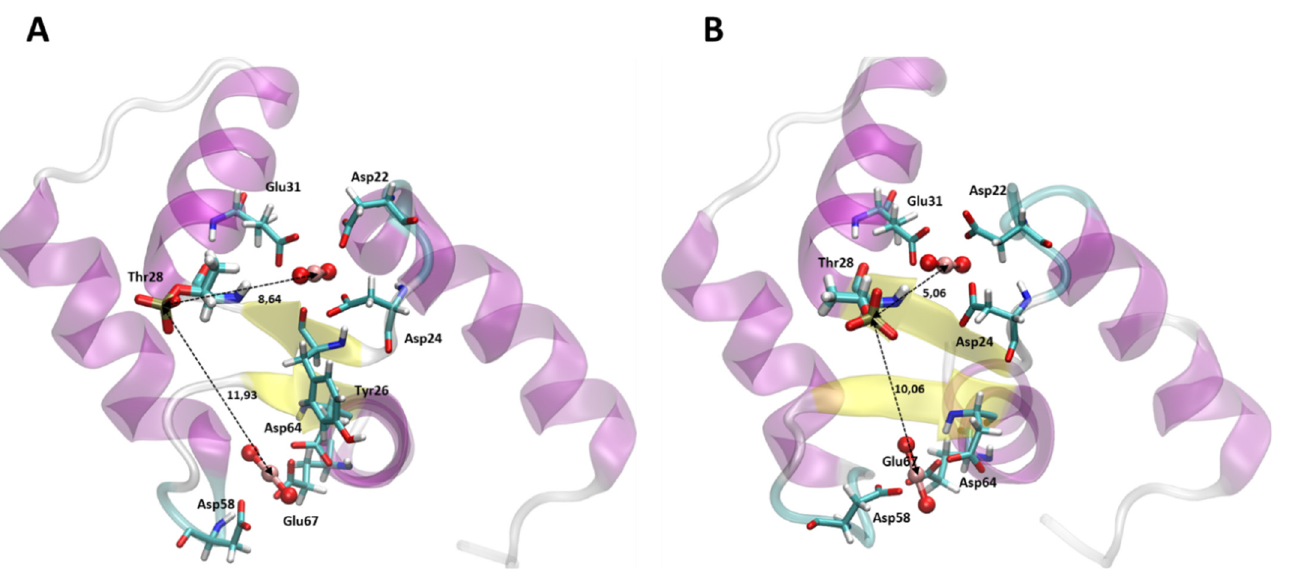
Figure 6. Structures of the calmodulin CaM1 Y I-II P system obtained after 12 ns MD simulation with a polarized force field ( A ) without restraints ( B ) following the introduction of restraints before starting the simulation. Residues with at least one atom closer than 2.5 Å to the uranyls (in CPK) are represented in licorice. Distances between the P atom of the phosphorylated threonine and uranium atoms are also given. The numbering used in this figure is that of the global N-ter domain, composed of 77 amino acids. Here is the correspondence referring to the numbering of metal-binding sites used in this article: Asp22 corresponds to Asp3 of site I, Asp24 to Asp5 of site I, Tyr26 to Tyr7 of site I, Thr28 to Thr9 of site I and Glu31 to Glu12 of sites I; Asp58 corresponds to Asp3 of site II, Asp64 to Asp9 of site II and Glu67 to Glu12 of site II. Table 5. Analysis of the coordination sphere of the two uranyl molecules in CaM1 Y I-II P from the structural model obtained by molecular dynamics simulation. Mean of distances (in Å) calculated from the 1500 last steps of the 15 ns simulation.